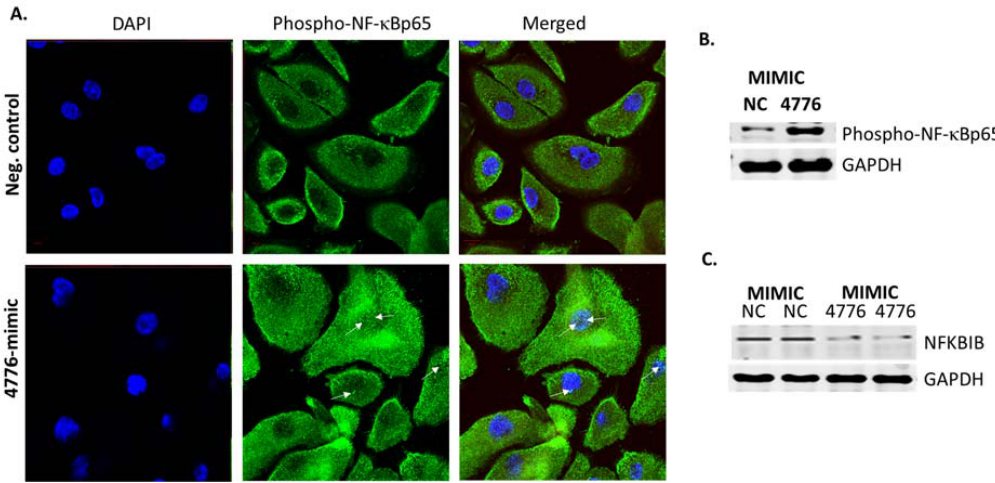
Figure 6. Immunofluorescence of IAV infected cells showing the expression of NF- κ B. ( A ) HBEpCs were transfected with miR-4776 mimic or a negative control. After 48 h of incubation, the cells were infected with 1 MOI of IAV for another 4 h. (NC represents the negative control and is a scrambled oligonucleotide) (top panel), miRNA-4776 mimic (bottom panel). The expression of activated phospho-NF- κ B p65 protein (green) was determined by immunofluorescence. 4 (cid:48) ,6-diamidino-2-phenylindole (DAPI) (blue) stained the nucleus of the cells. Arrows indicate the NF-kB translocated into the nucleus; ( B ) HBEpCs transfected with miR-4776 mimic or a negative control. After 48 h of incubation, the cells were infected with 1 MOI of IAV for another 4 h. Western blot analysis of cells transfected with mimic miR-4776 showing increased phospho-NF- κ B p65 protein; ( C ) immunoblot showing the decreased expression of NFKBIB protein in cells transfected with miR-4776 and infected with IAV. HBEpCs transfected with miR-4776 mimic or a negative control. After 48 h of incubation, the cells were infected with 1 MOI of IAV for another 4 h. GAPDH is used as the housekeeping